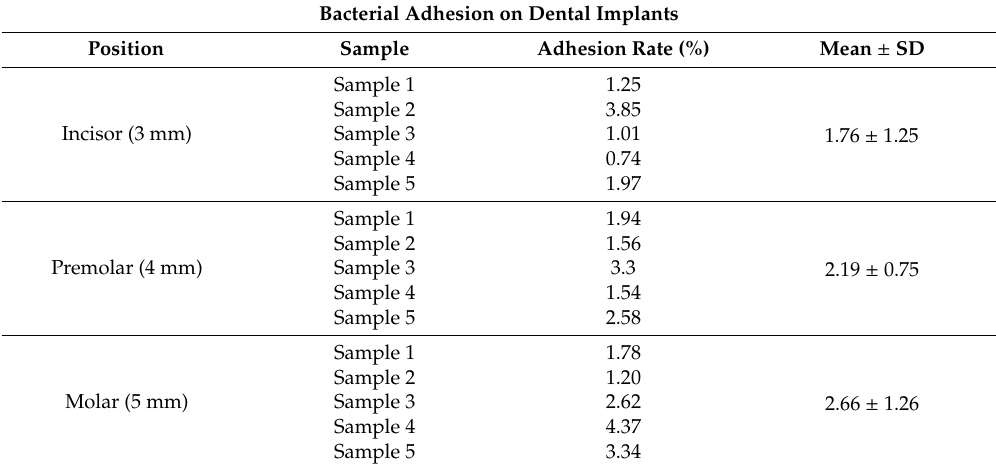
Table 2. Bacterial adhesion on di ff erent sandblasted and acid-etched dental implants with deep (6 mm) intra-bony defects at di ff erent tooth positions.